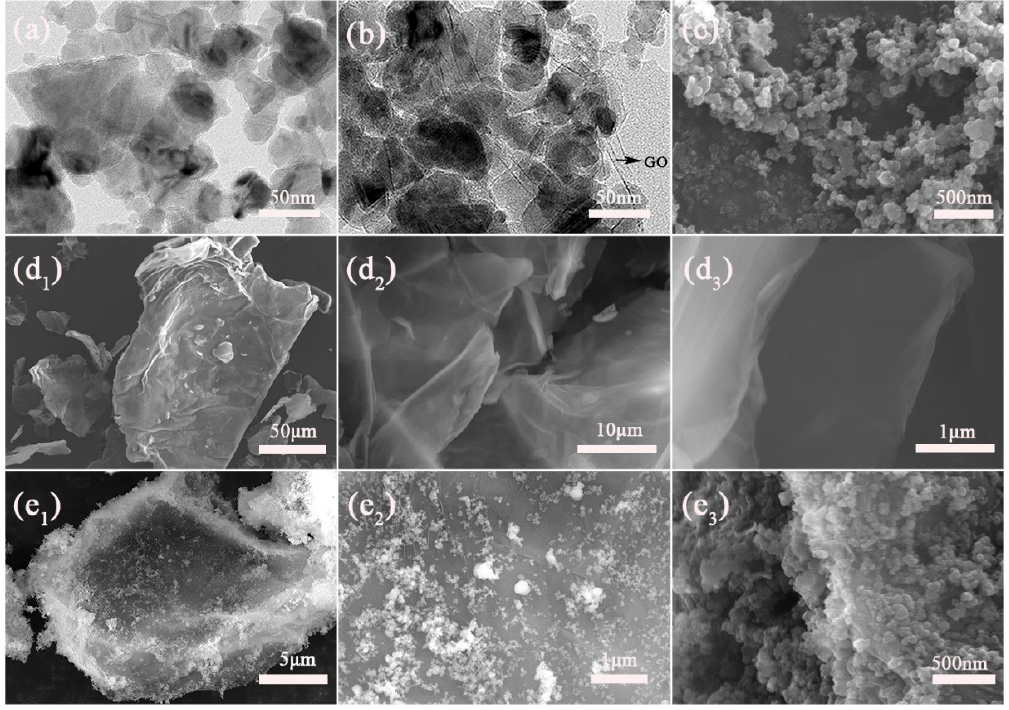
Figure 7. ( a , b ) TEM images of the ( a ) SiC and ( b ) SiC-G@GO samples, the black arrow is GO.; ( c – e ) FE-SEM images of ( c ) SiC, ( d ) GO, pictures with different magnification( d 1 – d 3 ), and ( e ) SiC-G@GO, pictures with different magnification ( e 1 – e 3